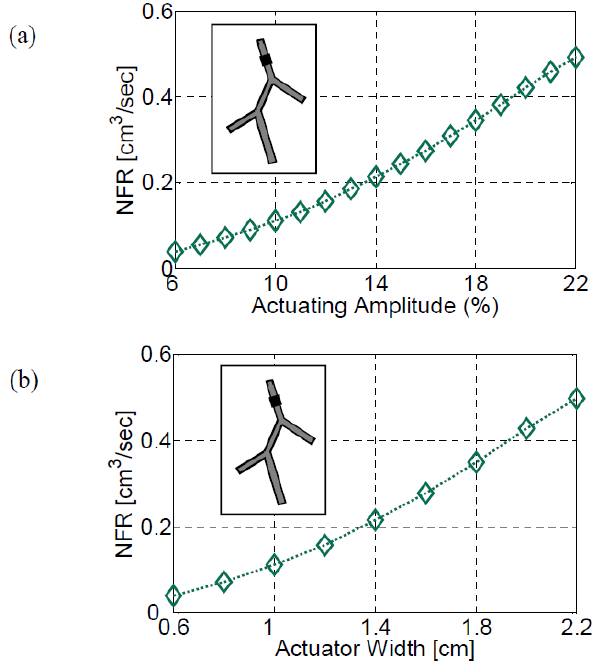
Figure 12. The effect of the actuation amplitude ( a ) and the actuator width ( b ) for configuration V. The actuation frequency was f = 6.42 Hz. For the study of amplitude effect on the NFR ( a ), the width of the actuator is W p = 1 cm. For the study of actuator width effect ( b ) the actuation amplitude is 10%. The actuator was located at X C / L = 0.4 of the first vessel.